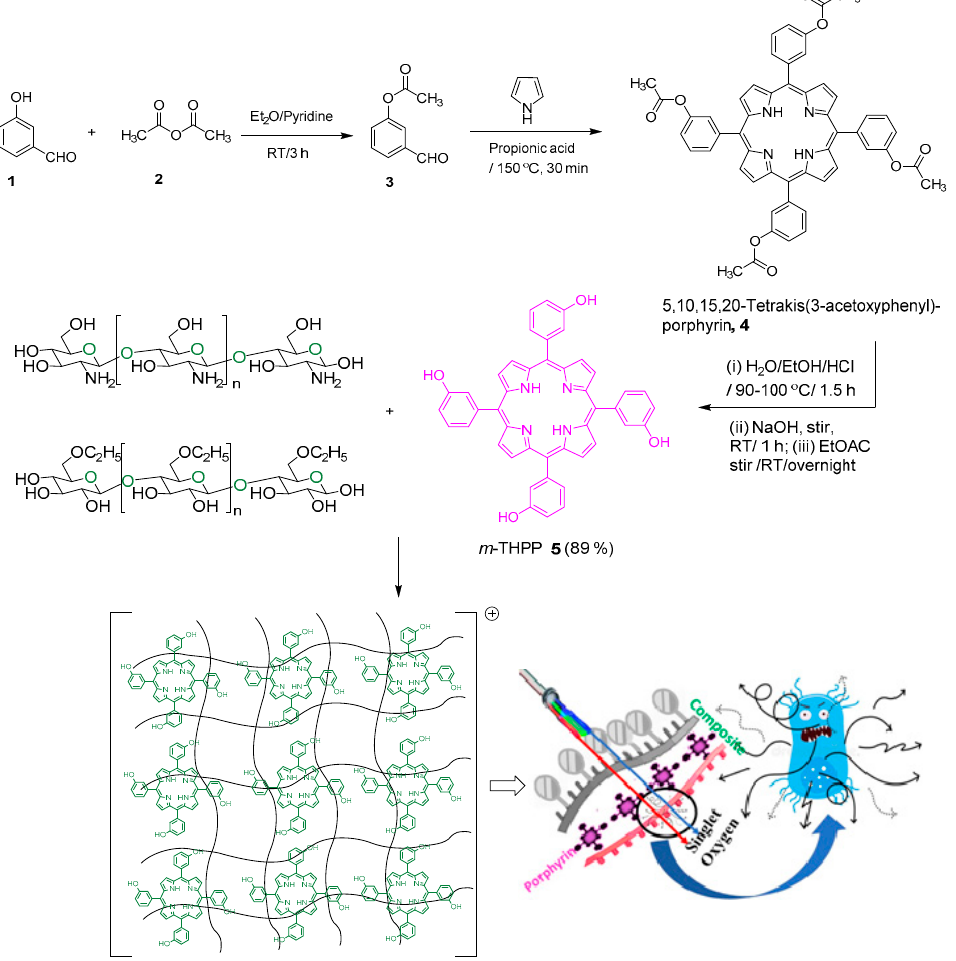
Figure 1. Design and synthesis of m THPP EC/Chs nanocomposite for aPDT.